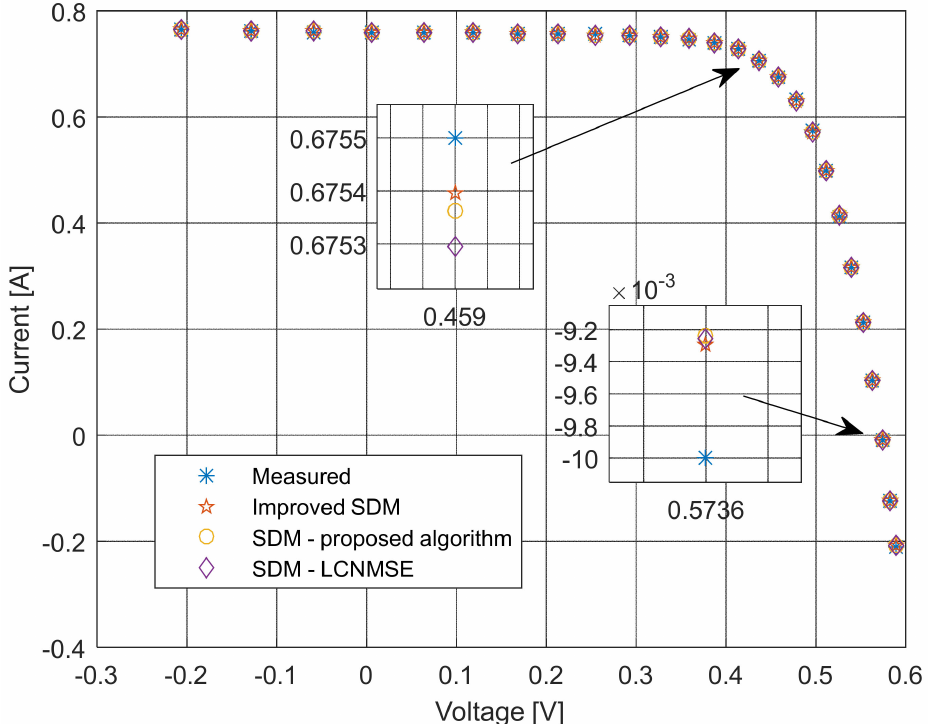
Figure 10. Current–voltage characteristics using different methods for both SDM and ISDM.